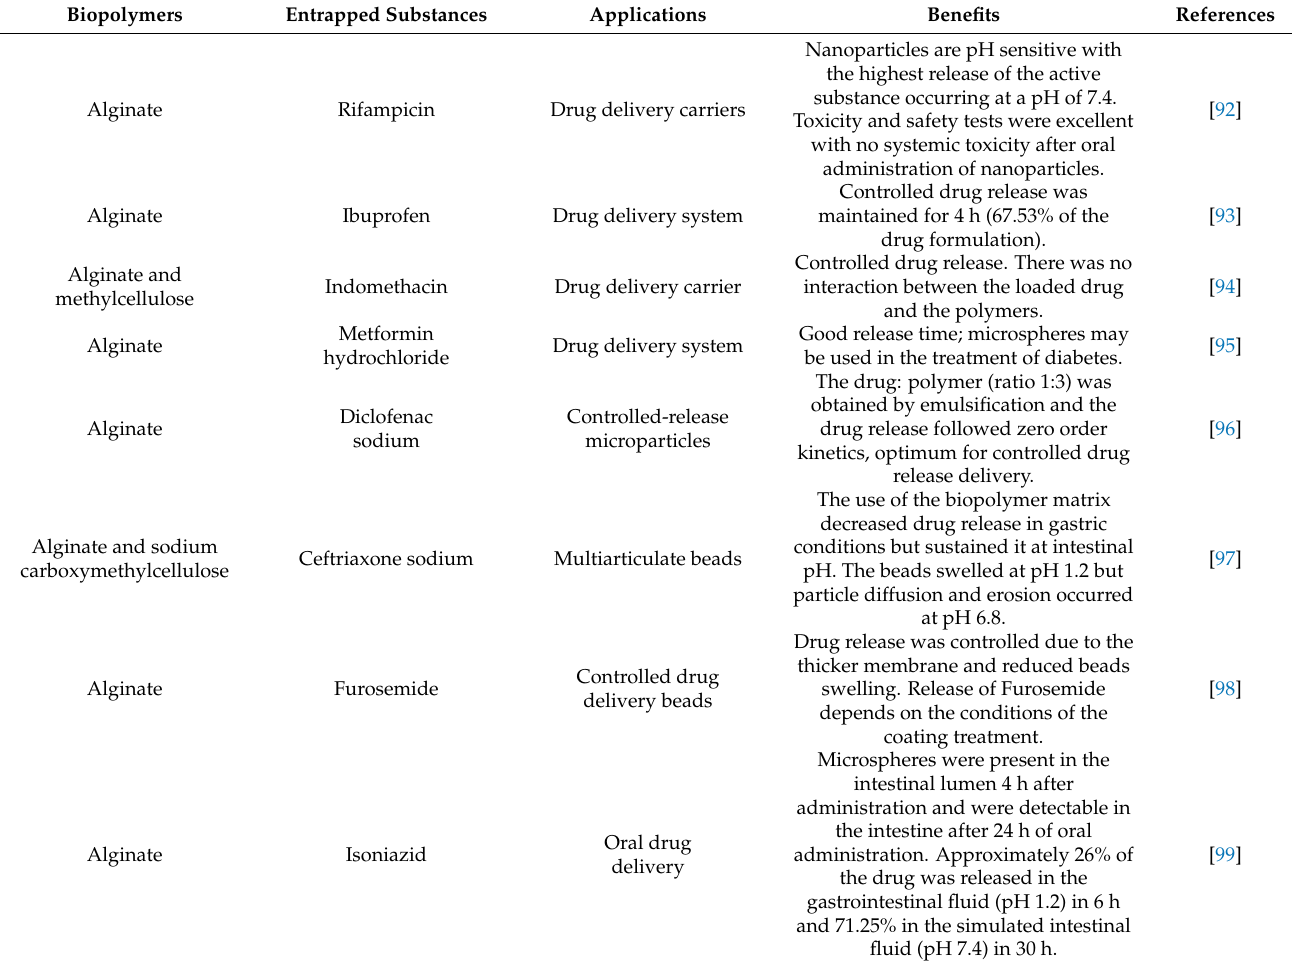
Table 2. Alginate use for drug